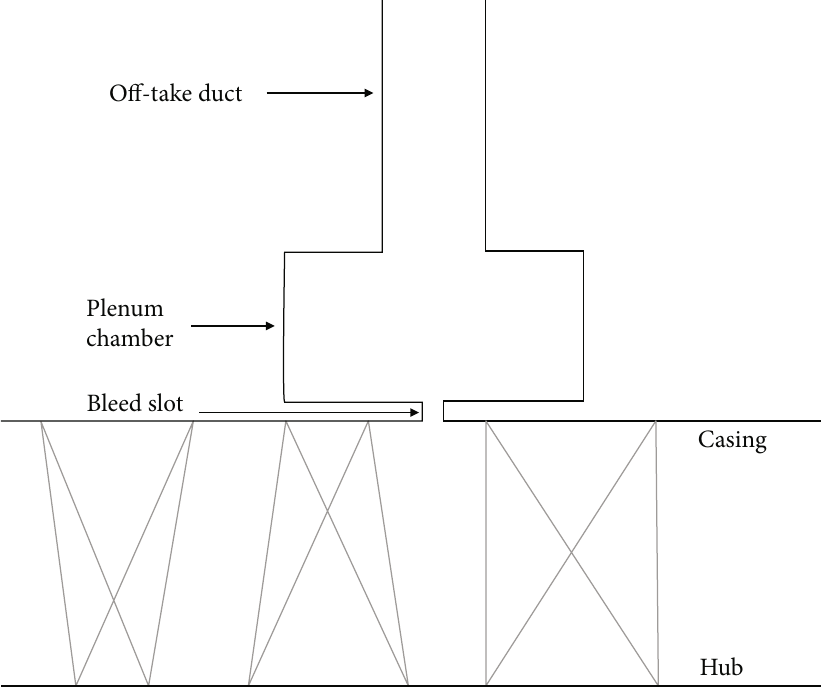
Figure 1: Meridional cross-section of compressor. Table 1: Geometric parameters of plenum